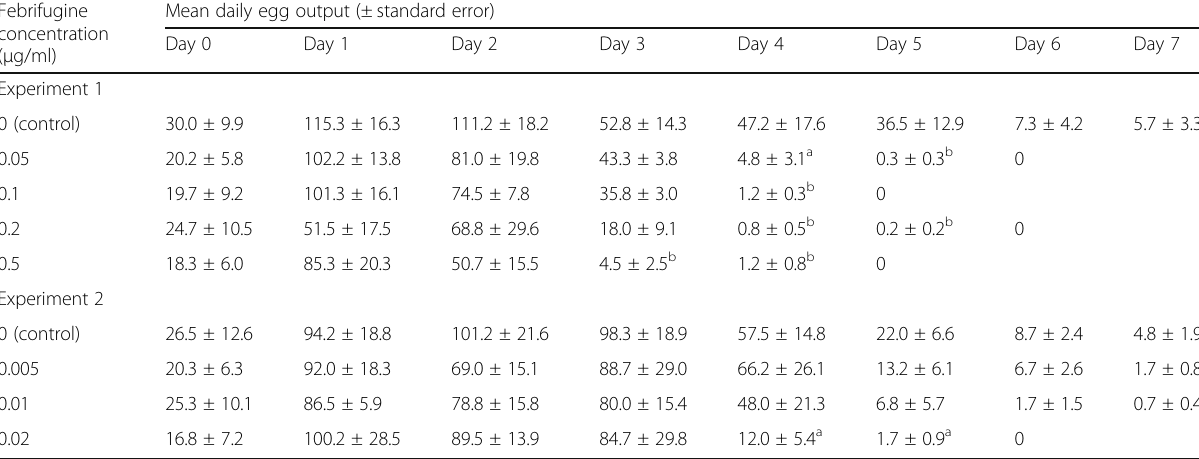
Table 1 Inhibitory effect of febrifugine on the daily egg output of six paired Schistosoma mansoni adult worms within 7 days Febrifugine